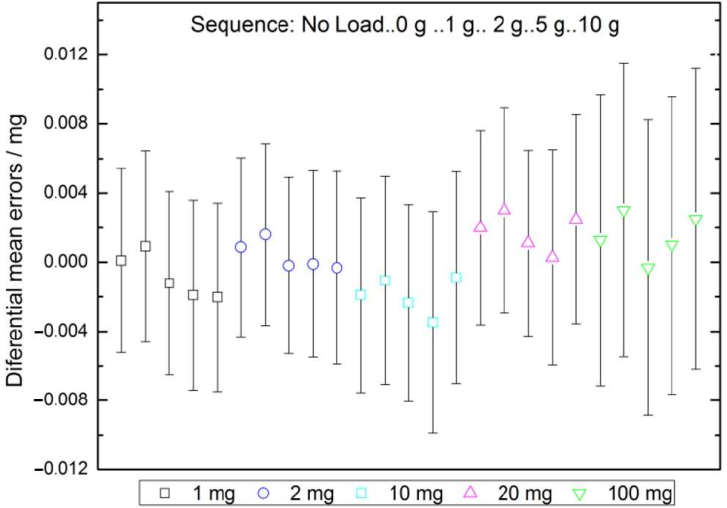
Figure 10. Mean differential errors .